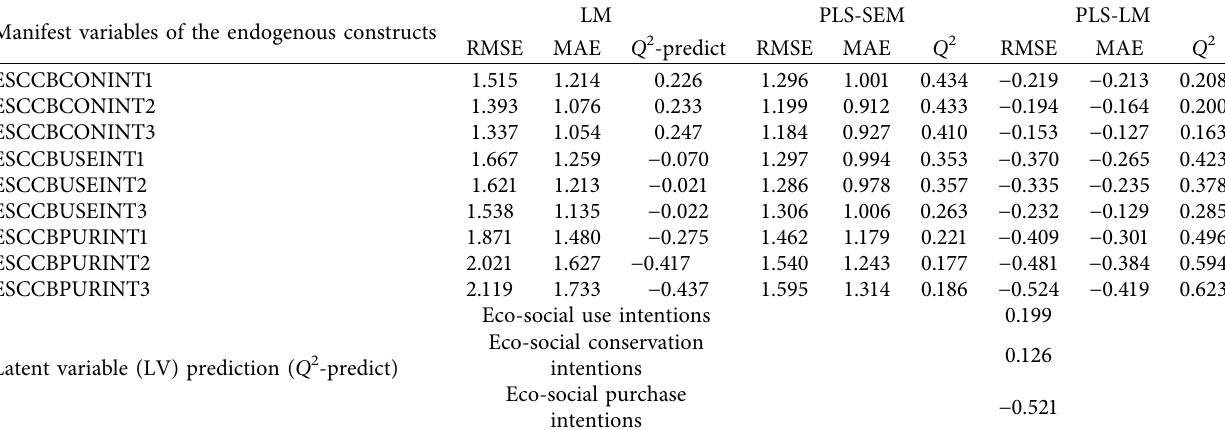
Table 7: Predictive validity score from PLS-predict module. Manifest variables of the endogenous